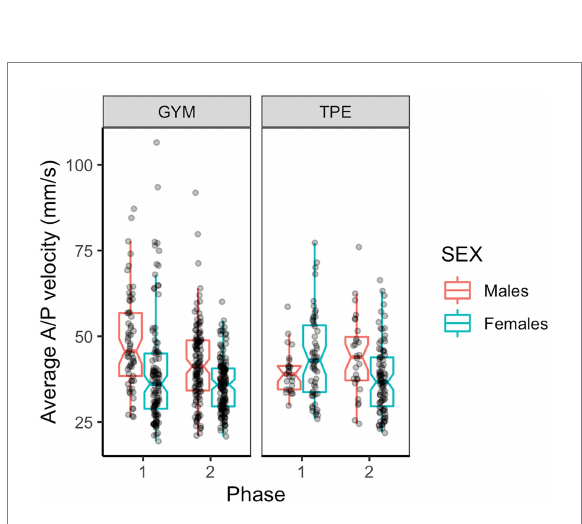
FIGURE 6 Mediolateral sway velocity for males and females in the GYM and TPE